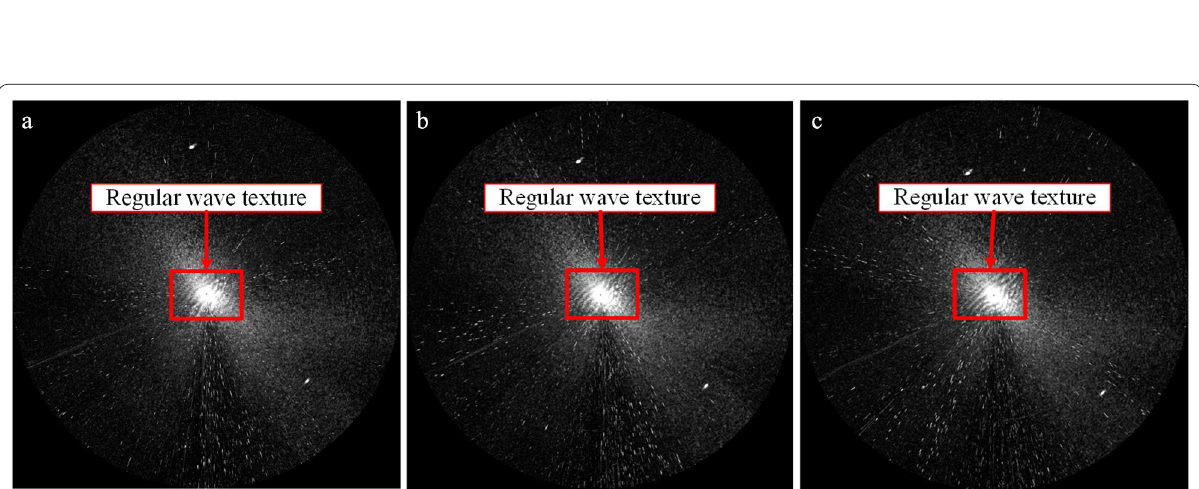
Fig. 10 Regular wave texture images with suspected oil film features. a – c Were collected at 14:51:19, 14:51:50 and 14:52:19 on August 12, 2015,